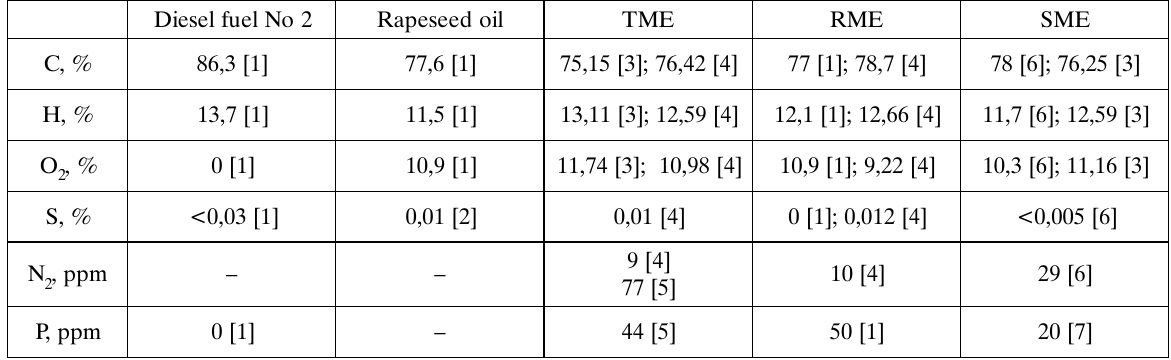
Table 1. Elemental composition of fuel 2oNleufleseiD